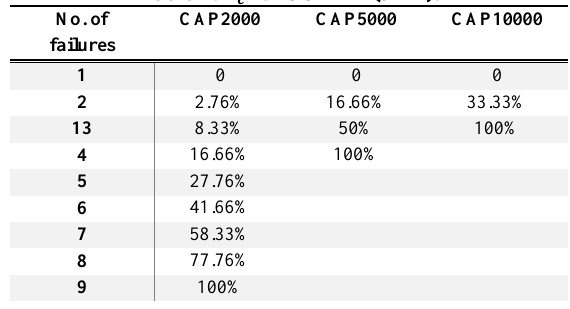
Table 1. 𝑹 𝒄 for UUNET (OPT). No.